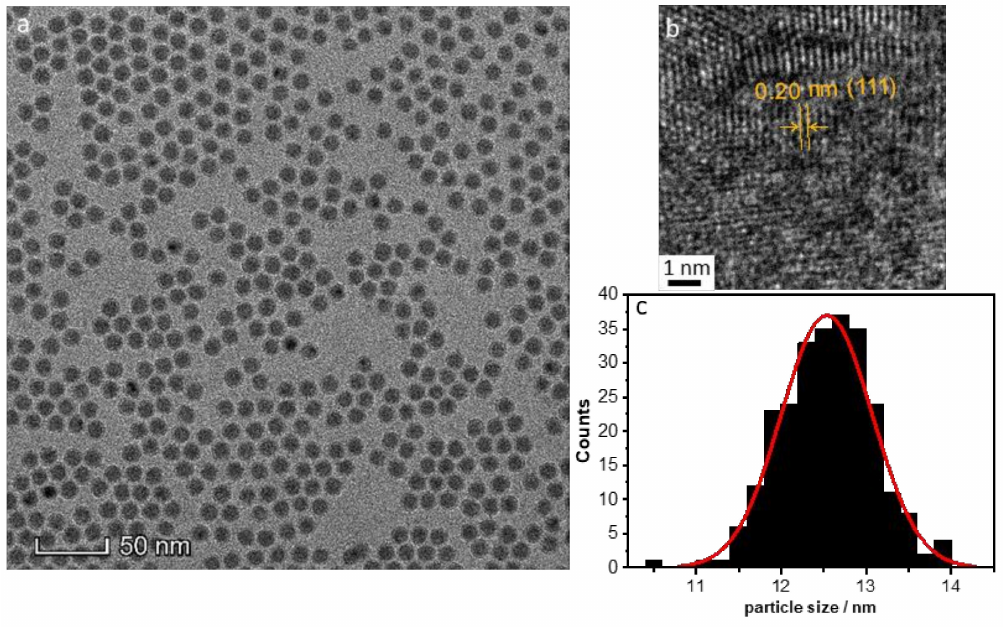
Figure 1. ( a ) TEM image of highly monodisperse NiNPs (diameter = 12.5 ± 0.5 nm); ( b ) zoomed-in TEM image revealing lattice fringes of 0.20 nm in NiNPs indicating fcc Ni (111); ( c ) particle size distribution of